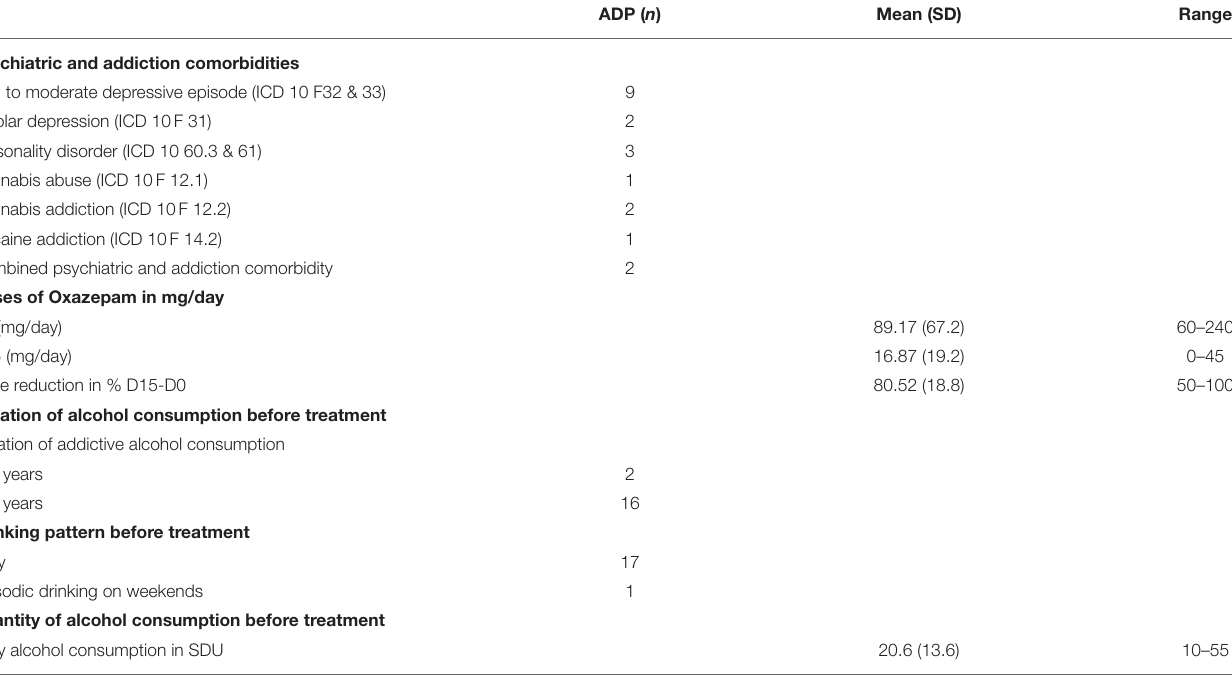
TABLE 2 | Psychiatric clinical use characteristics of alcohol dependent patients (ADP). ADP ( n ) Mean (SD)